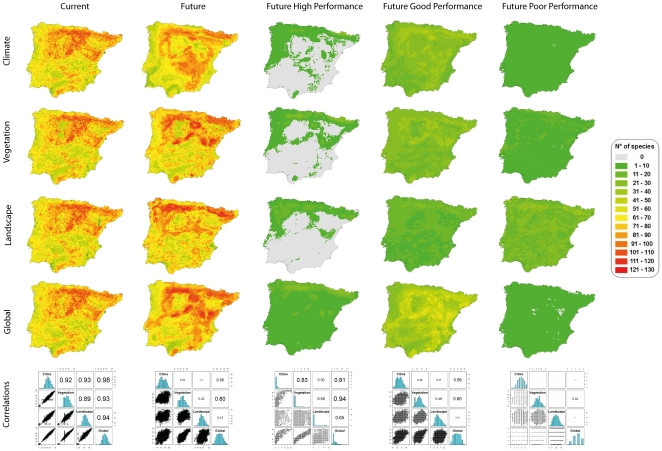
Spatial pattern comparison of bird distributions.The maps represent the total number of species per each 10 km cell for the four model types (Climate, Vegetation, Landscape and Global) and for two time periods (current and future projections). The correlation graphs indicate the level of agreement between the four model types for each column. The calculations for the first two columns (current and future) were done using the total number of bird species (N = 168) whereas the last three columns illustrate subsets of the future projection based on model performance categories (AUC method): high (N = 32), good (N = 63) and poor (N = 37).